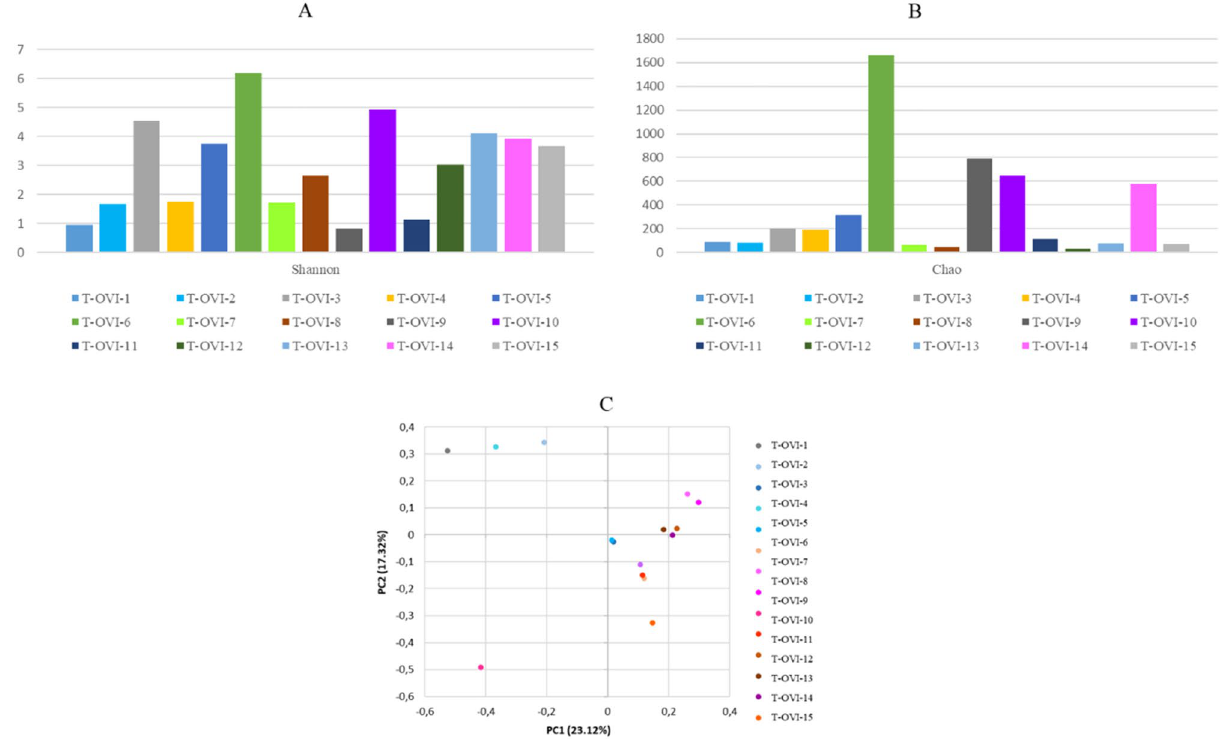
Figure 2. ( A ) Shannon index of each oviduct sample; ( B ) Chao index of each oviduct sample; ( C) PCoA plots based on Bray–Curtis distance. Each point represents an oviduct sample. Farm A- blue tones, farm B pink tones.